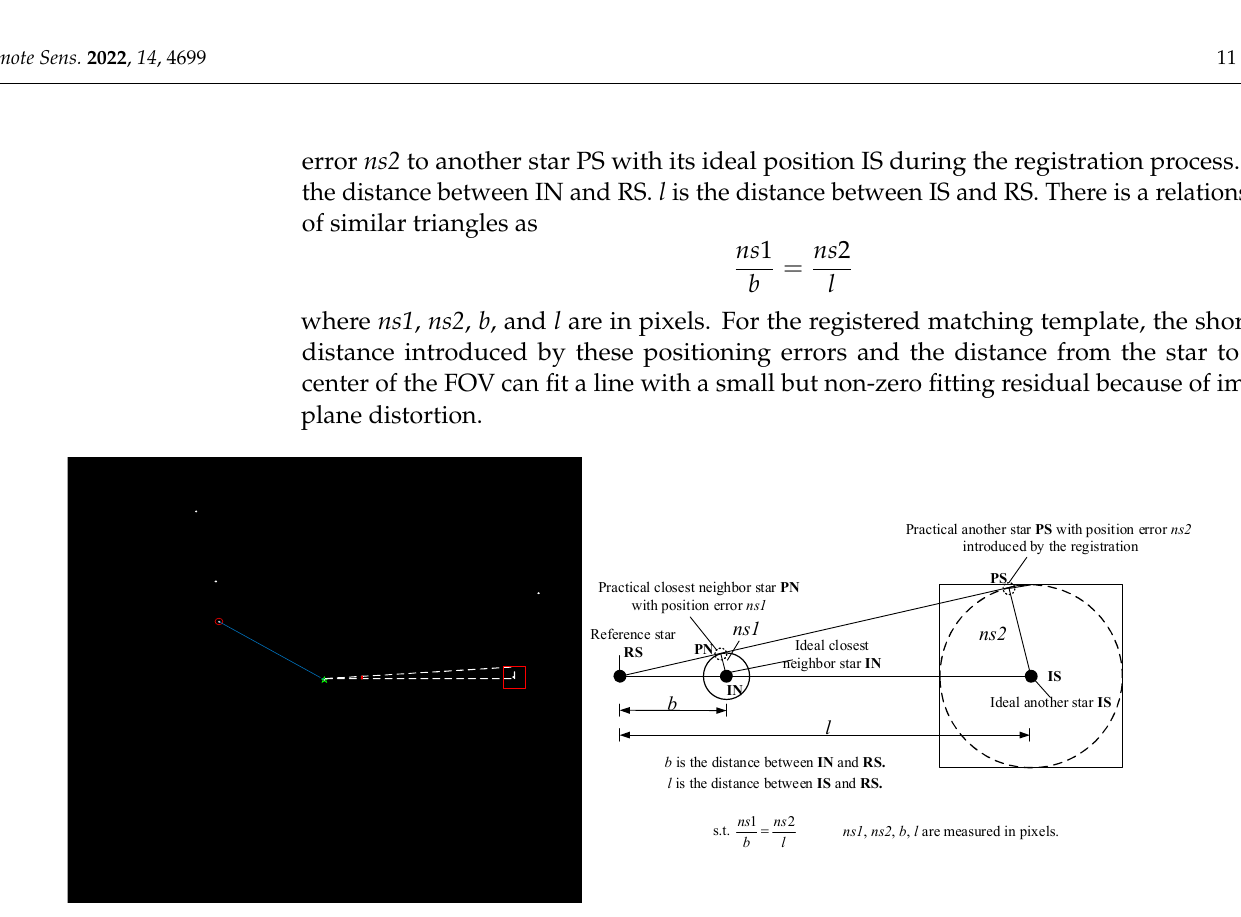
Figure 8. The registration process will introduce additional star positioning errors proportional to the distance from the star to the center of the FOV. the distance from the star to the center of the